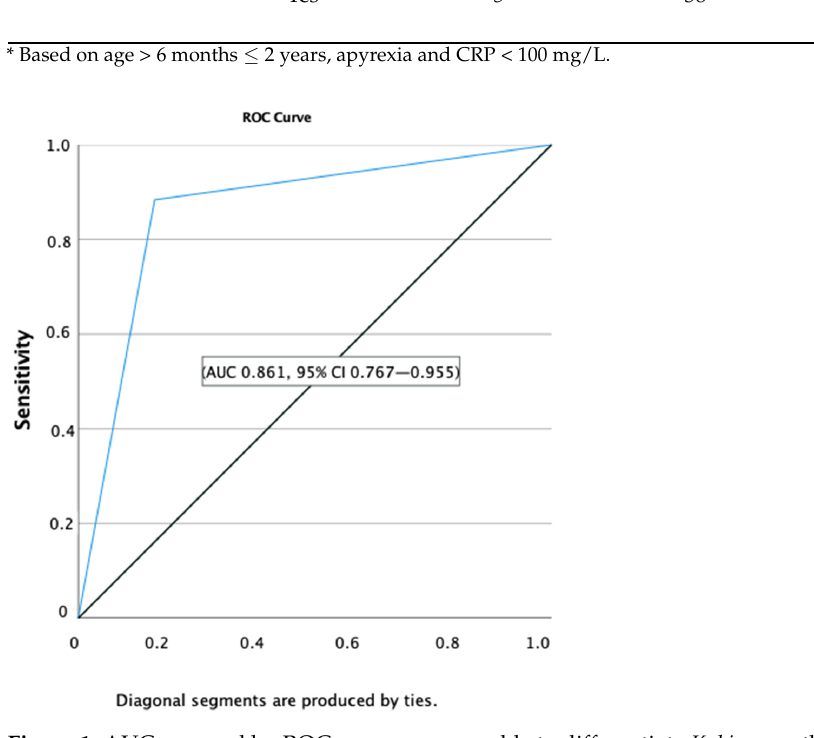
Figure 1. AUC assessed by ROC curves was capable to differentiate K. kingae arthritis from typical pathogens, for this model.